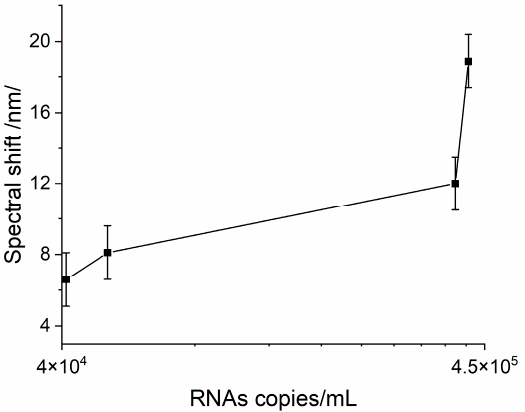
Figure 5. SPR response as a result of the Hb–VLP interaction at di ff erent concentrations .